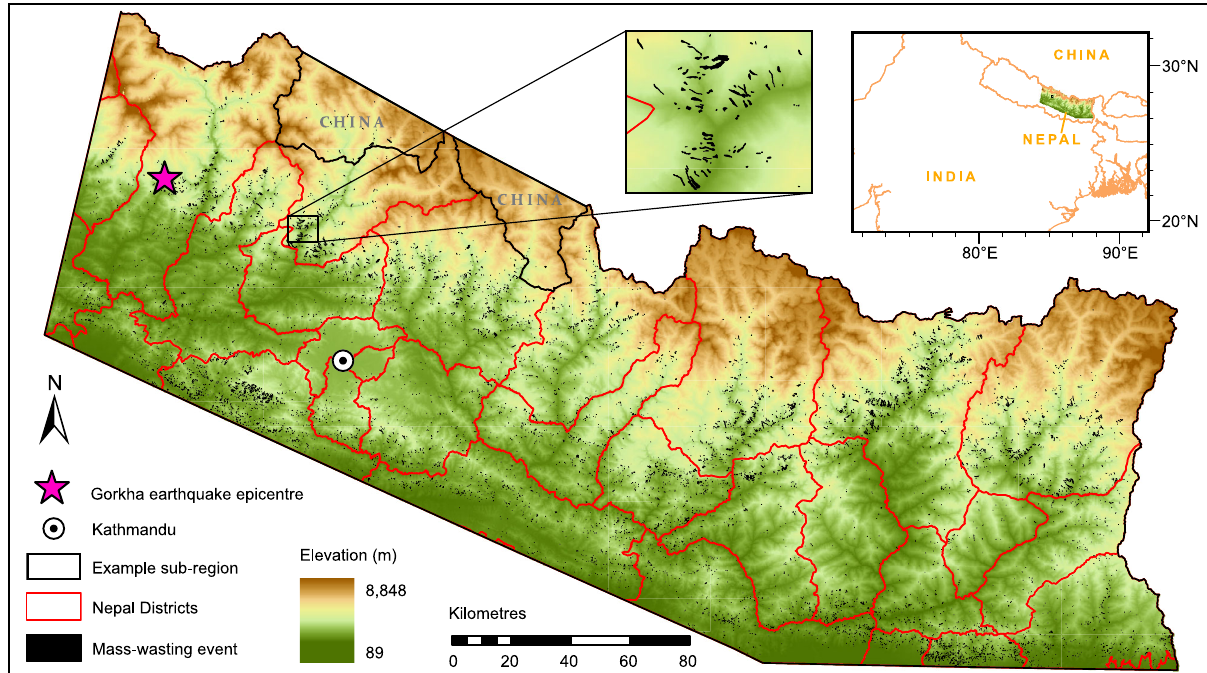
Fig. 1 Location of the study region and all 12,290 mapped monsoon-triggered mass-wasting features. This includes a detailed view of a smaller sub- region demonstrating the detail of the mapped polygons. Also shown are the outlines of all Nepal Districts within the study region, including Kathmandu city and the Gorkha earthquake epicentre. Elevation data are derived from the ALOS World 3D (AW3D30) DEM developed by and copyrighted to the Japanese Aerospace Exploration Agency